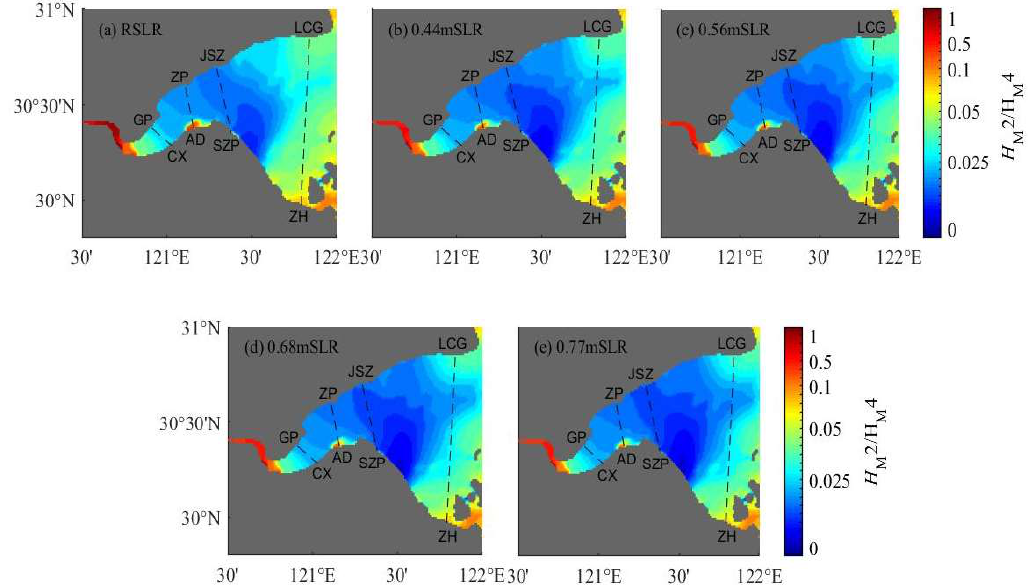
Figure 8. The ratio of the H M2 /H M4 variations under ( a ) RSLR, ( b ) 0.44 m SLR, ( c ) 0.56 m SLR, ( d ) 0.68 m SLR and ( e ) 0.77 m SLR in the Hangzhou Bay